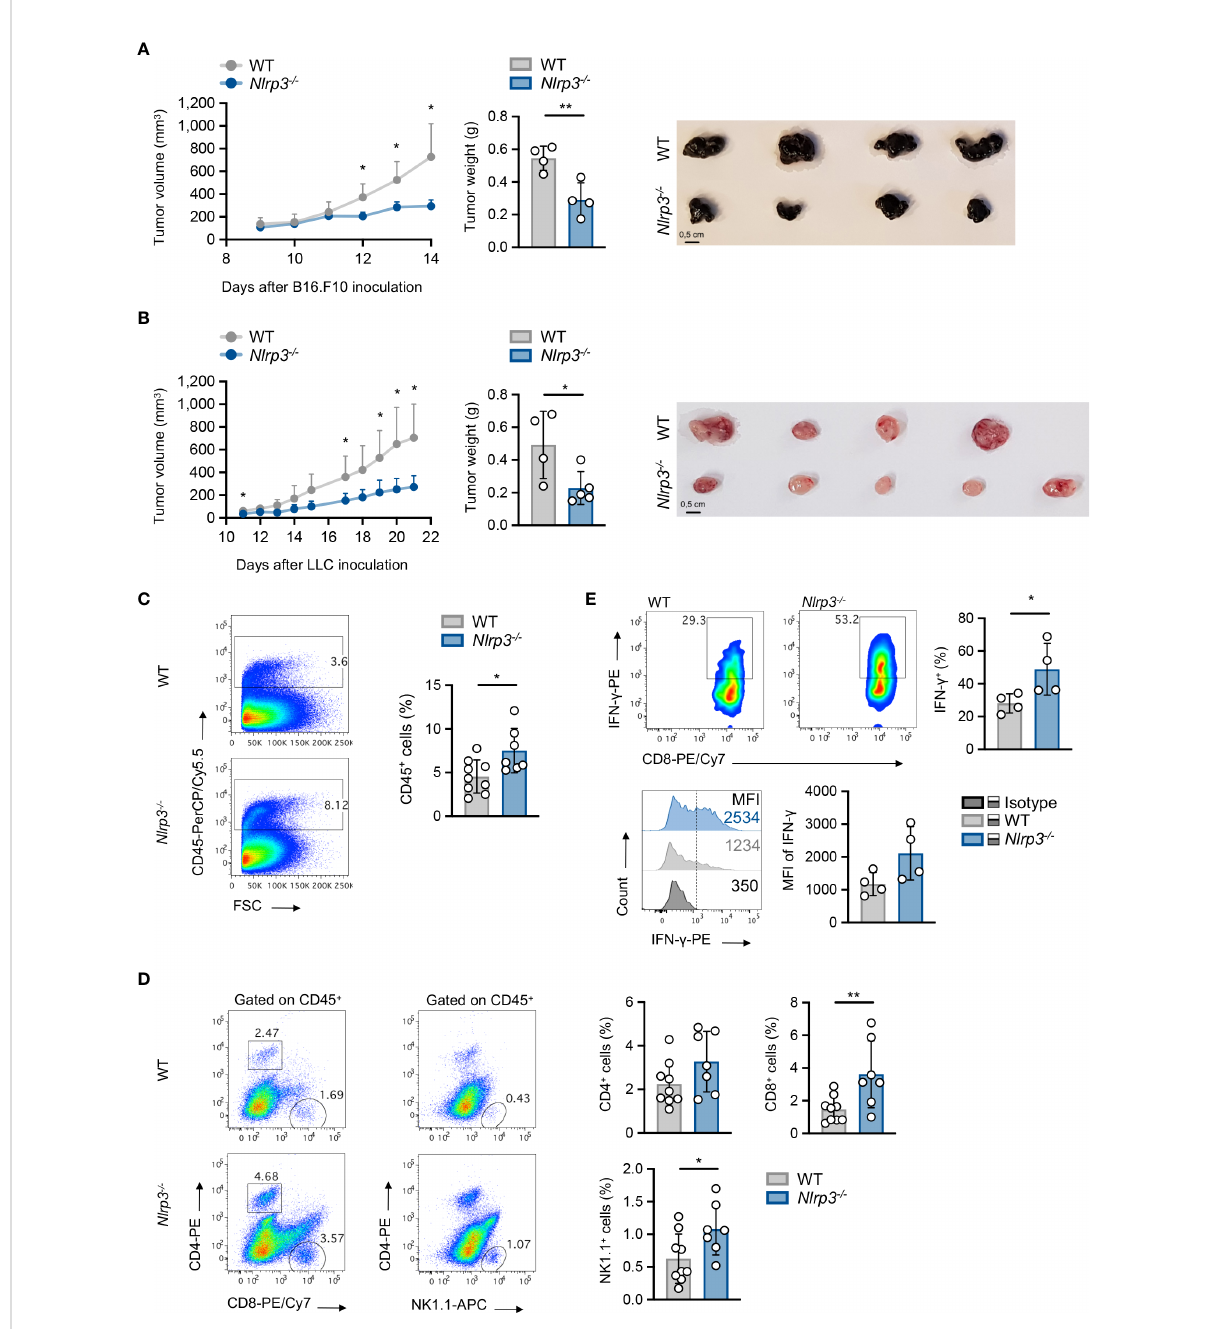
FIGURE 2 Nlrp3 de fi ciency promotes tumor regression and anti-tumor immunity. (A) Tumor volume curve of WT ( n = 4) and Nlrp3 -/- ( n = 4) mice 9 – 14 days after B16.F10 inoculation, tumor weight on day 14, and representative image of excised melanoma tumors. (B) Tumor volume curve of WT ( n = 4) and Nlrp3 -/- ( n = 5) mice 11 – 21 days after LLC inoculation, tumor weight on day 21, and representative image of excised LLC tumors. (C) Representative fl uorescence-activated cell sorting (FACS) plots and percentages of intratumoral CD45 + cells of WT ( n = 9) and Nlrp3 -/- ( n = 7) mice 15 days after B16.F10 inoculation. (D) Gating strategy and frequencies of intratumoral CD4 + , CD8 + , and NK1.1 + cells in CD45 + population of WT ( n = 9) and Nlrp3 -/- ( n = 7) mice 15 days after B16.F10 inoculation. (E) Representative FACS plots and frequencies of CD8 + IFN- g + cells from CD45 + tumor-in fi ltrating cells of WT ( n = 4) and Nlrp3 -/- ( n = 4) mice 15 days after B16.F10 inoculation, and representative overlay and mean fl uorescence intensity (MFI) of IFN- g produced by CD8 + cells after in vitro activation. Data are shown as mean ( ± S.D.). Representative data from at least two independent experiments are shown. Statistical signi fi cance was obtained by unpaired Student ’ s t -test. Symbols: (*), p ≤ 0.05; (**), p ≤ 0.01, n = biologically independent mouse